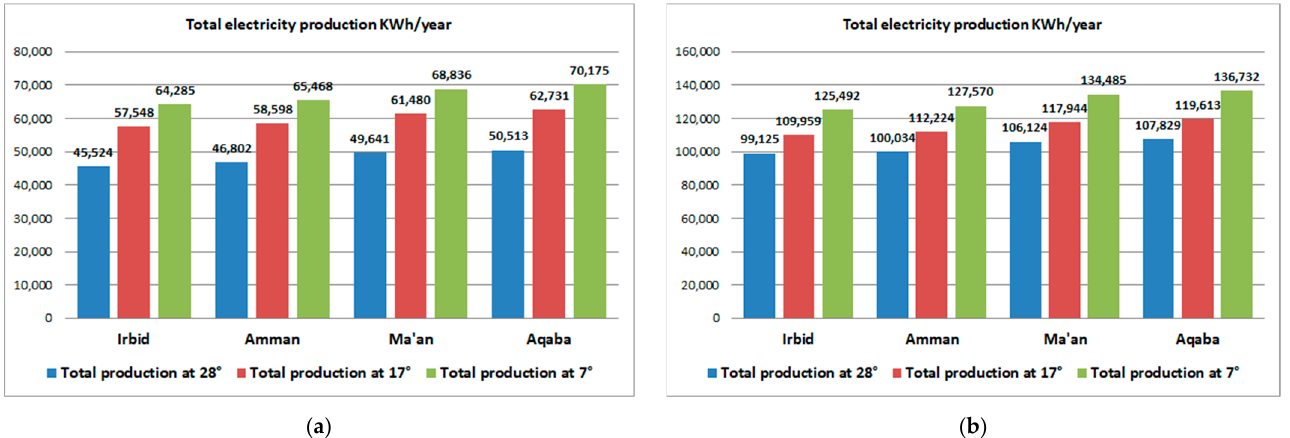
Figure 6. Total electricity production from the installation of PV systems on the rooftops of apartment buildings type ( a ) A1 and ( b ) A2.